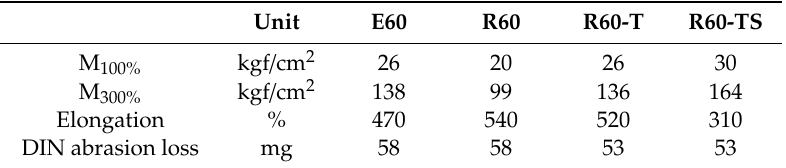
Figure 13. Mechanical properties of vulcanizates of emulsion styrene butadiene rubber (ESBR) and reversible addition-fragmentation radical transfer (RAFT) ESBR carbon black-filled compounds with a controlled cure system. Table 11. Mechanical properties and abrasion resistance of vulcanizates of emulsion styrene butadiene rubber (ESBR) and reversible addition-fragmentation radical transfer (RAFT) ESBR carbon black-filled compounds with a controlled cure